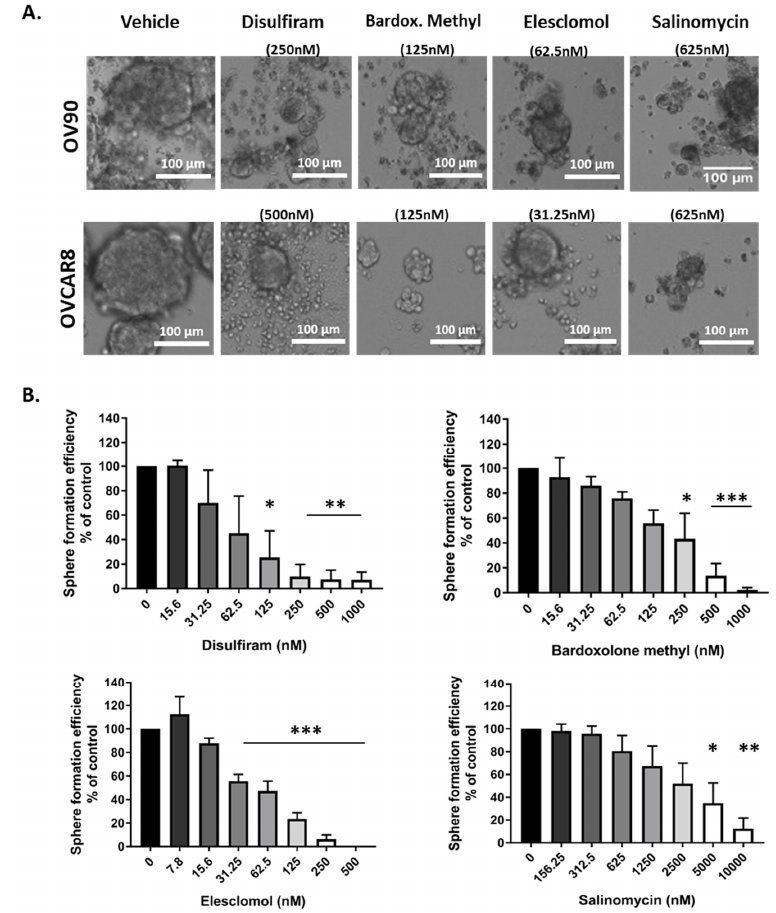
Figure 3. Sphere formation e ffi ciency of ovarian cancer cells exposed to the drugs. ( A ) The drugs break apart pre-formed spheroids after exposure to drugs for 72 h in OV90 cell line (top) and OVCAR8 (bottom). ( B ) OV90 sphere formation e ffi ciency was quantified in increasing concentrations of drugs as number of spheroids over 1000 µ m 2 . Graphs represent mean and SEM Graphs represent mean and SEM of each treatment, distinguished by di ff erent degrees of grayscale shading * p < 0.05, ** p < 0.01, *** p < 0.001 compared to vehicle